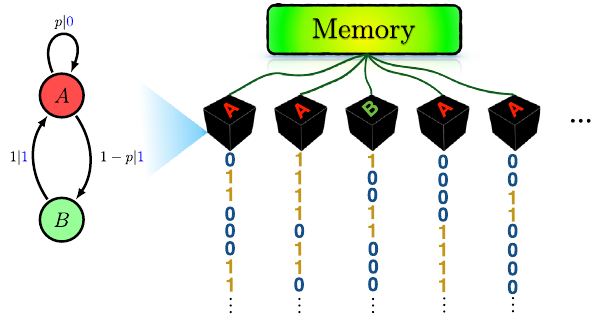
FIG. 2. Left: Even process ϵ -machine. Right: Schematic of simultaneous generation problem. Each black box contains an even process generator. They all share the same memory for tracking the individual generator